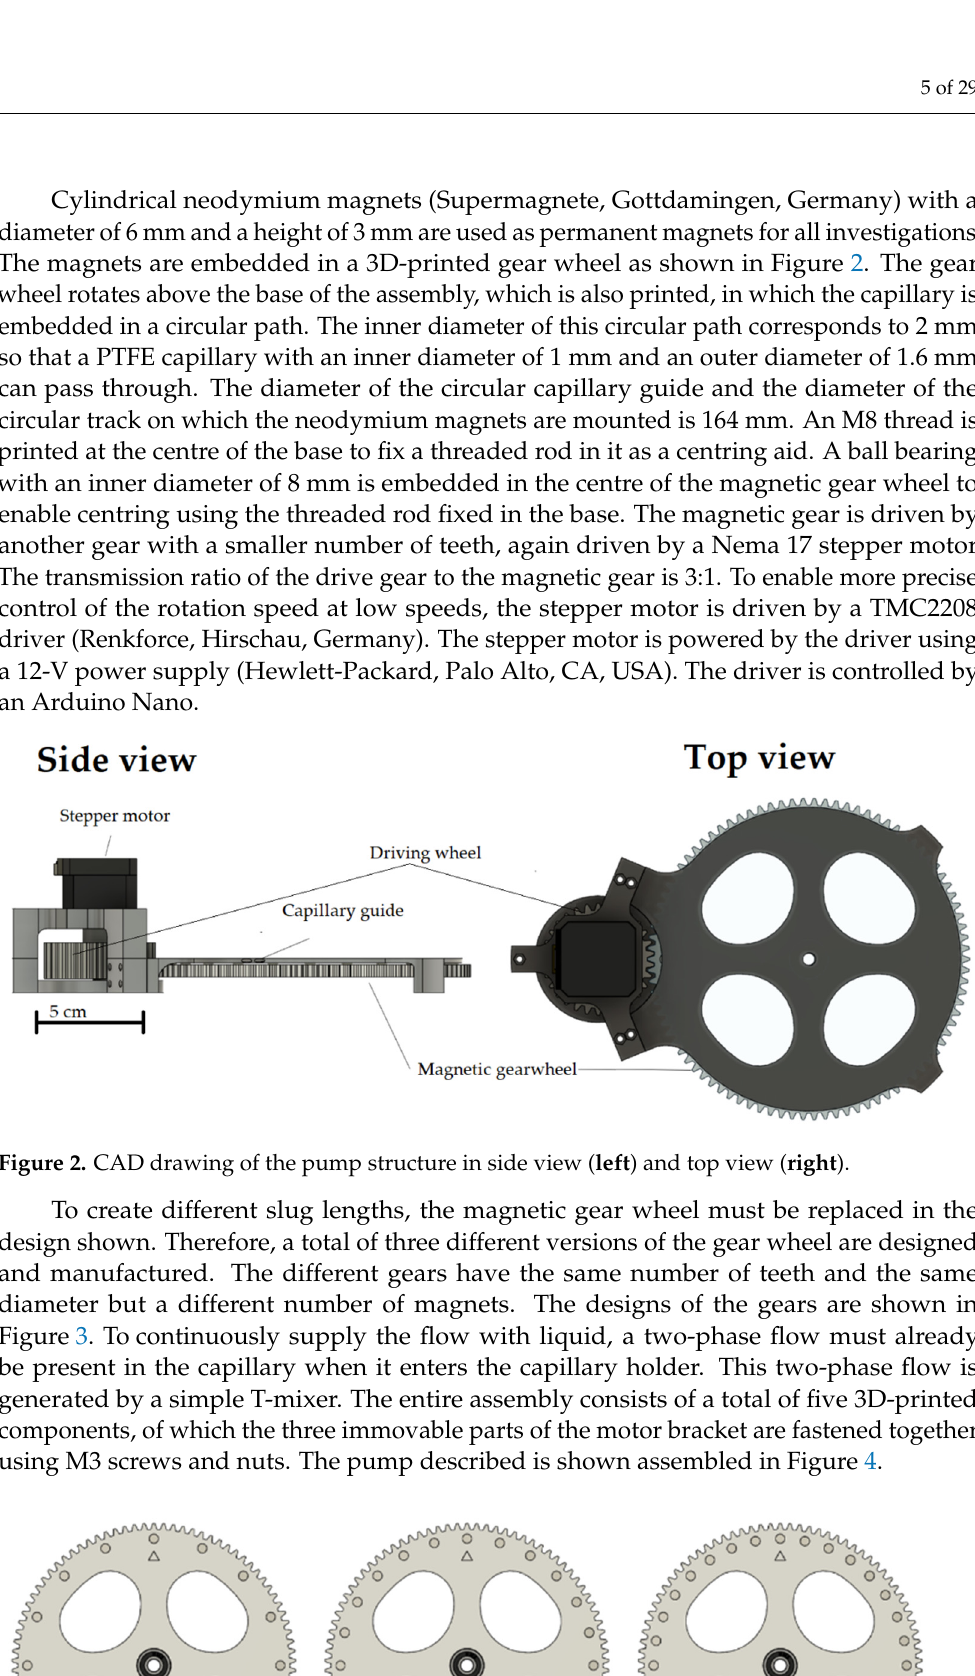
Figure 4. Design of the magnetic gear pump with recessed capillary and an uneven two-phase flow.